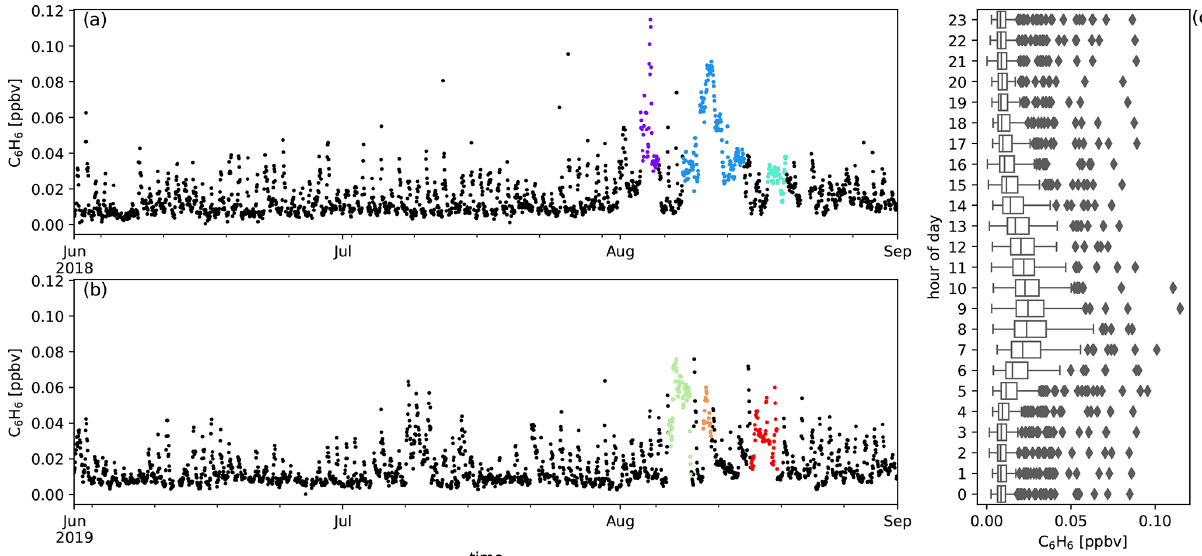
Figure A7. Measured C 6 H 6 mixing ratios (ppbv) during austral winter 2018 (a) and austral winter 2019 (b) together with the diel distribution of hourly averages (c) . Biomass burning plumes under investigation are highlighted in